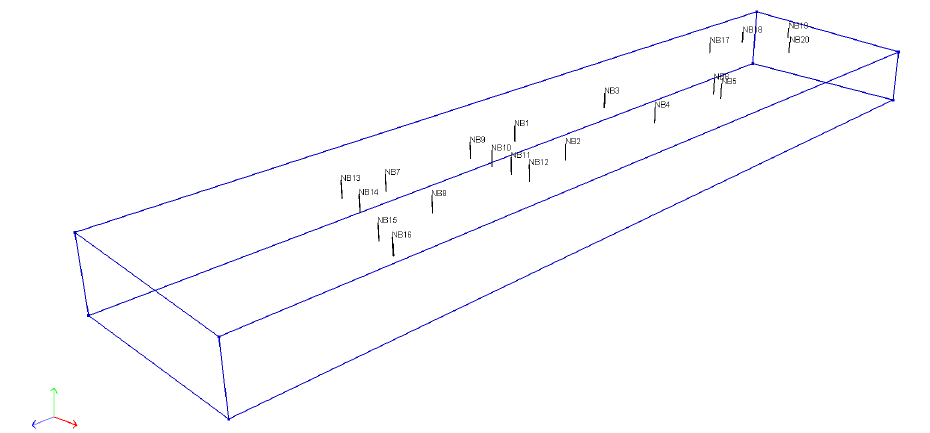
Figure 4: Location of the boreholes and the dam body – top view. Fig. 4. Location of the boreholes and the dam body – top view Fig. 4. Location of the boreholes and the dam body – top view